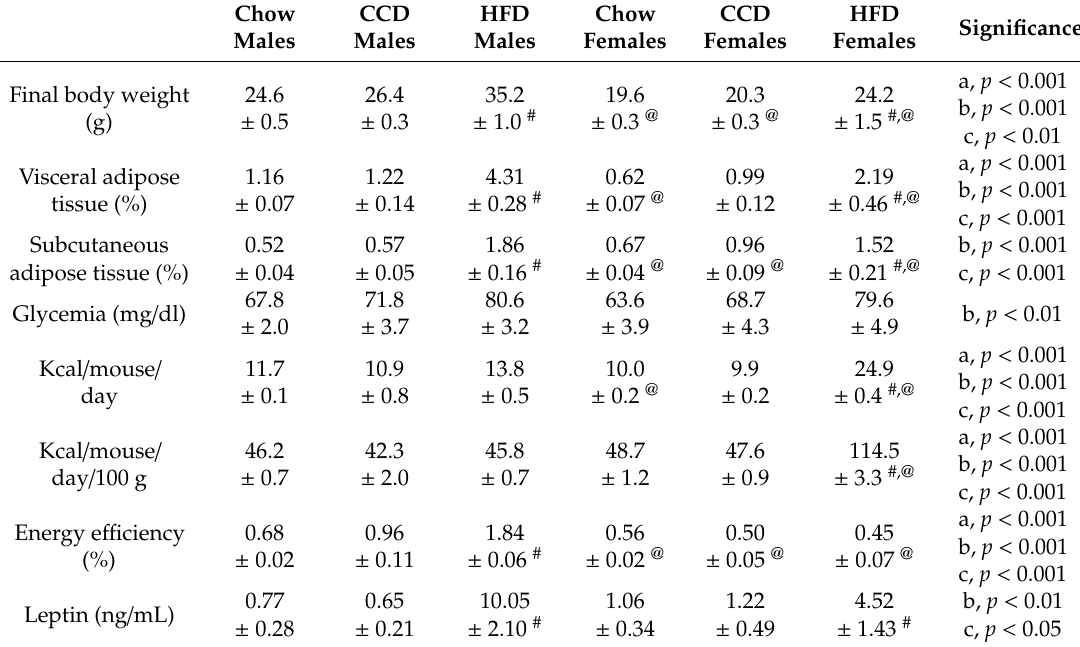
Table 1. Body weight, fat mass, glycemia, energy intake and circulating leptin levels in male and female mice exposed for 8 weeks to a high-fat diet (HFD), commercial control diet (CCD) or a chow diet. a: e ff ect of sex, b: e ff ect of diet, c: interaction between sex and diet, #: di ff erent from chow on the same sex, @: di ff erences between sexes on the same diet, n = 6, except energy intake was n = 3 (number of cages /